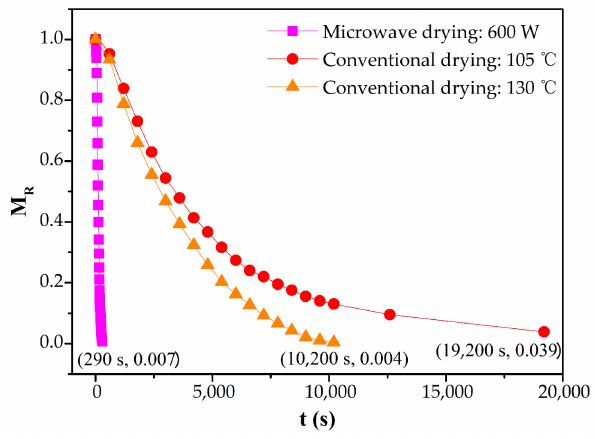
Figure 7. Variations of moisture ratio of CRES with time in the microwave and conventional dry- ing processes.